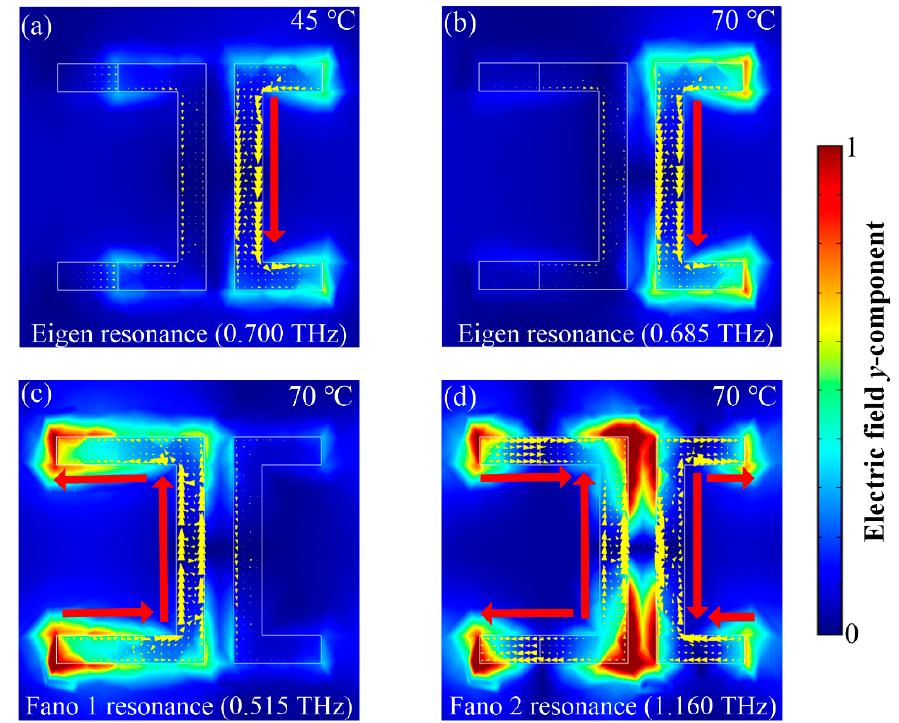
Figure 5. Surface current and electric filed distributions of the proposed VO 2 -implanted MM structures at the frequencies of Fano resonances for the low and high temperatures. ( a ) Eigen resonance (0.700 THz) at 45 °C. ( b ) Eigen resonance (0.685 THz), ( c ) Fano 1 (0.515 THz), and ( d )_Fano 2 (1.160 THz) at 70 °C.